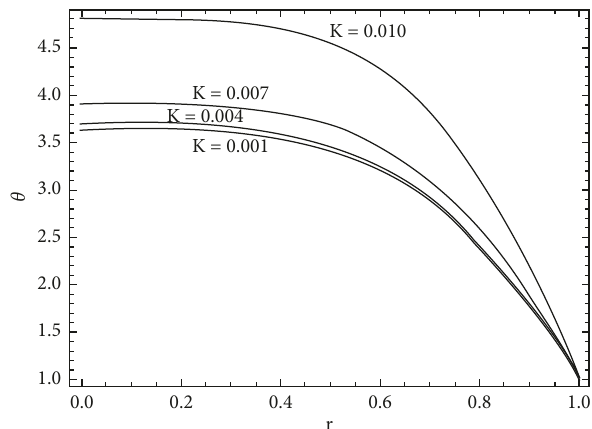
Figure 10: Variation of τ Figure 13: Variation of θ with r for different values of K , where 2 , where ω with z for different values of We P 0 � 43, K � 0.001, n � − 1, and m � 0.5. P 0 � 43, z � 0.1, B r � 1, We 2 � 0.0001, n � − 1, and m �